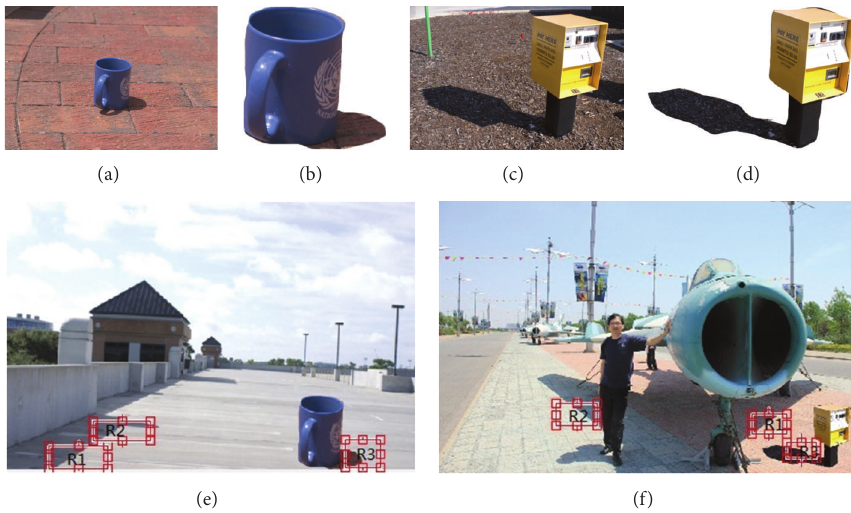
Figure 5: Examples of forged image where shadow as well as main body is copied and pasted from another image.